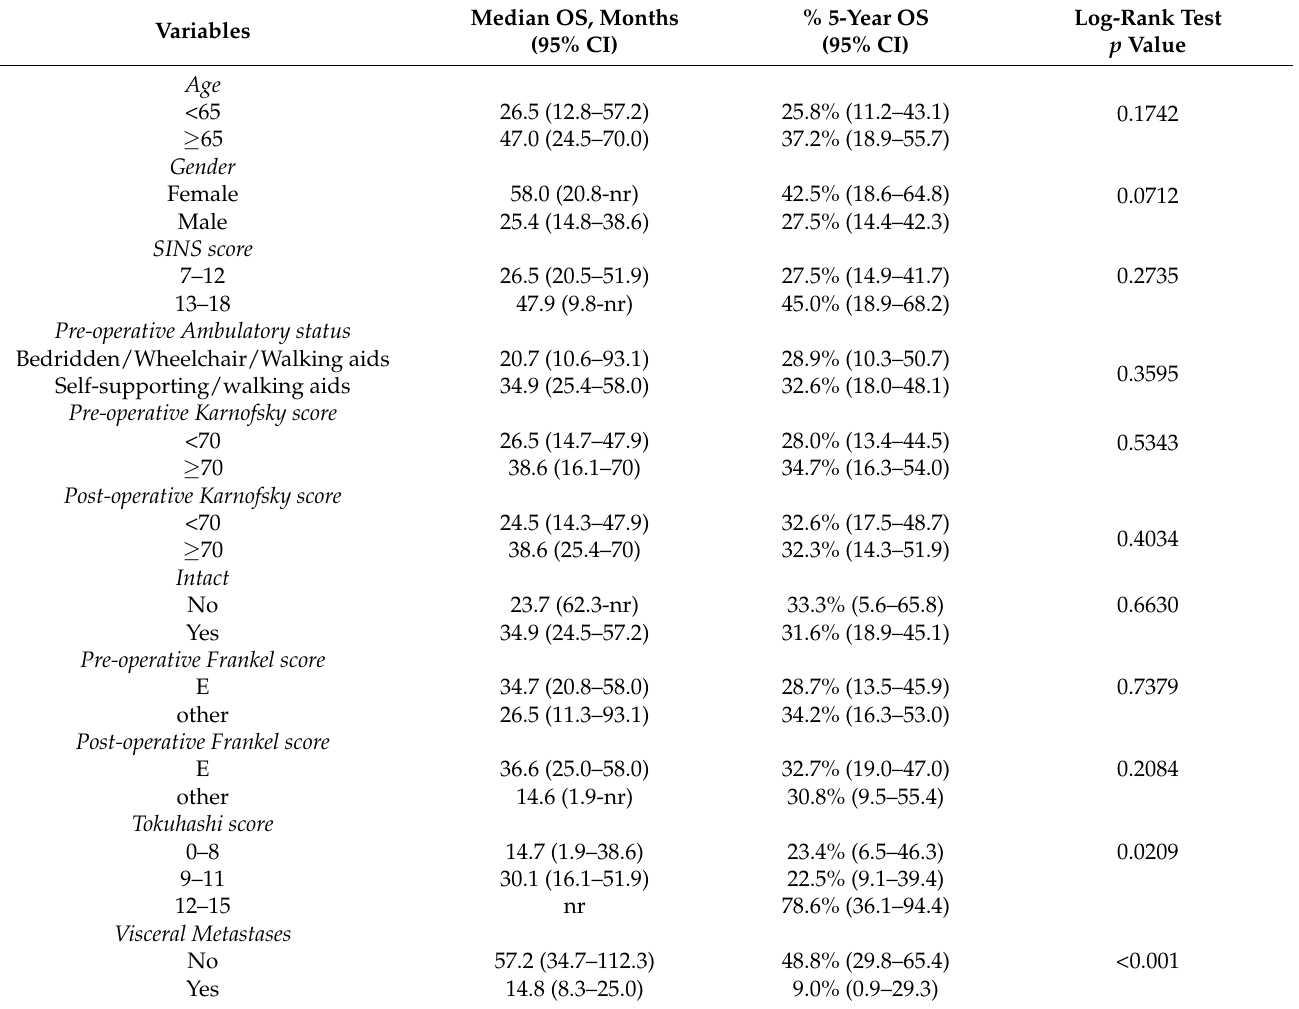
Table 5. Univariate analysis of the prognostic factors affecting overall